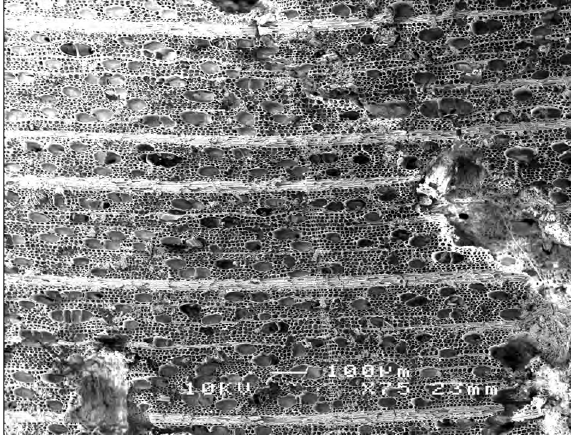
Figure 8: Maple ( Acer sp. ), grave 4, cross-section (SEM micrograph: Otto Cichocki)